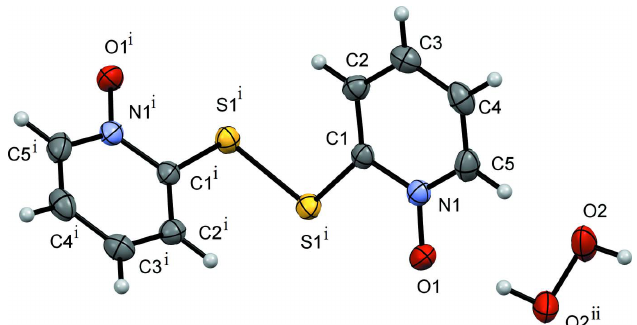
Figure 1 A view of the molecular structure of the title compound, with displacement ellipsoids drawn at the 50% probability level. [Symmetry codes: (i) (cid:5) x + 1, (cid:5) y + 1, z ; (ii) 1 (cid:5) x , 1 (cid:5) y , z .]